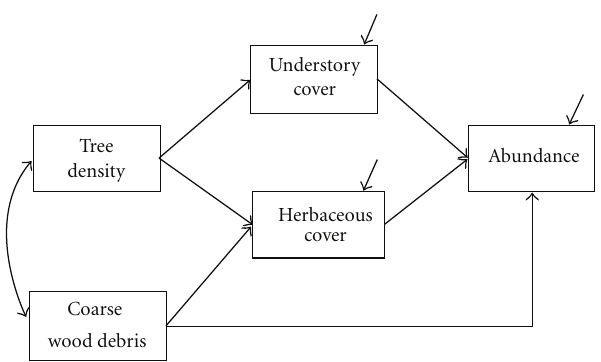
Figure 1: A hypothetical path model for abundance of a small mammal species in mature forests. Single arrowheads linking two variables depict direct e ff ects and double arrowheads linking two variables depict unanalyzed associations. Arrows pointing towards the understory cover, herbaceous cover, and abundance represent errors associated with the endogenous